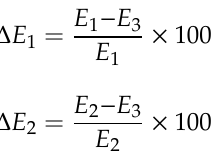
Figure 4. Experimental model of the hybrid defense system (HDS).